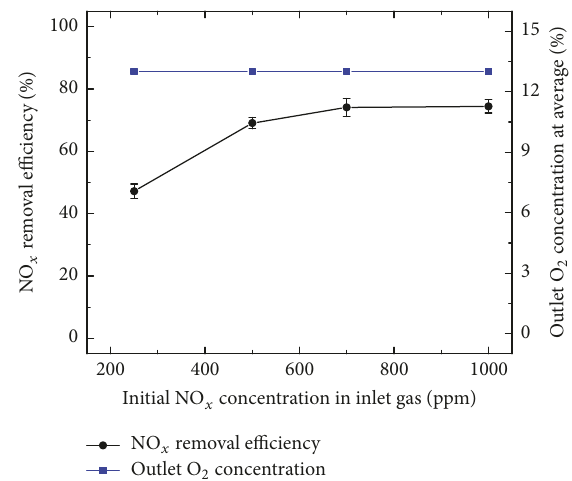
Figure 8: NaClO solution pH after scrubbing for 20 min (gas flow is 1.25 L/min, inlet NO concentration is 1000ppm, initial CO 2 x concentration is 5%, NaClO concentration is 0.05 M, and solution temperature is 293 K).